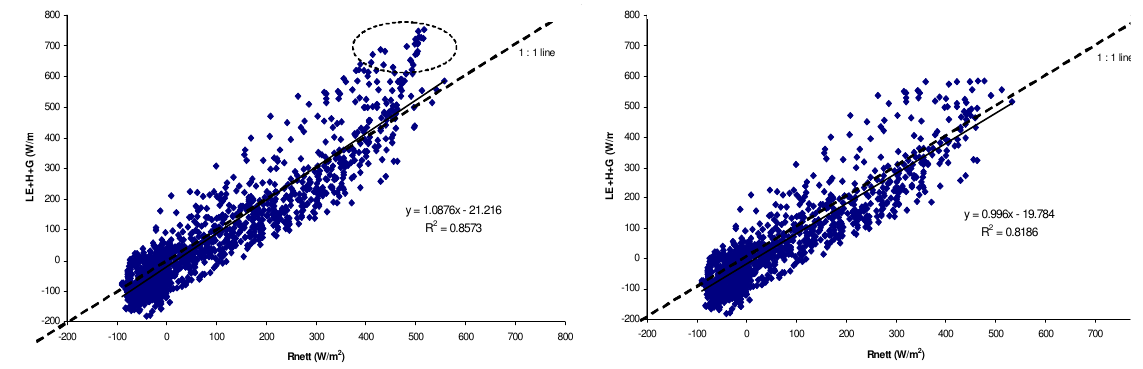
Fig. 4. Energy balance closure for daytime periods over a three week period during the spring of 2005 with 1:1 line and linear relation. In the left plot a circle is drawn around the outlying mid-day data points. In the right plot mid-day measurements are removed. is in agreement with the power law in the inertial